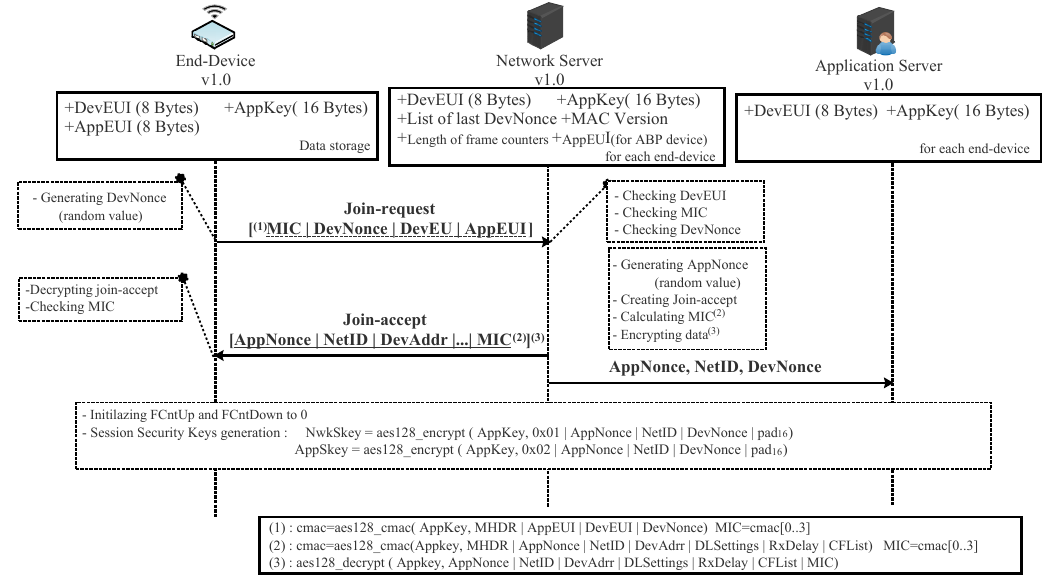
Figure 5. OTA end-device joining a network server in scenario 1.